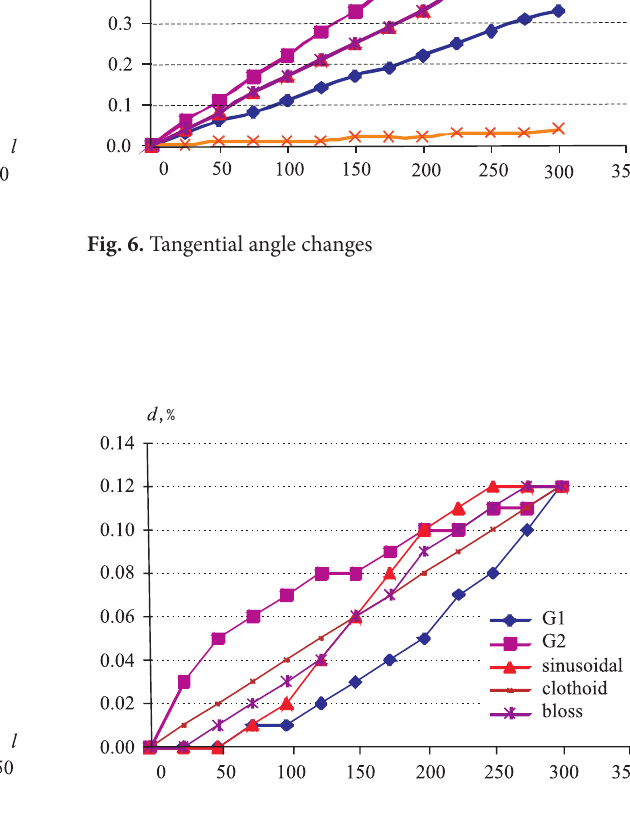
Fig. 7. Lateral acceleration changes Fig. 8. Superelevation